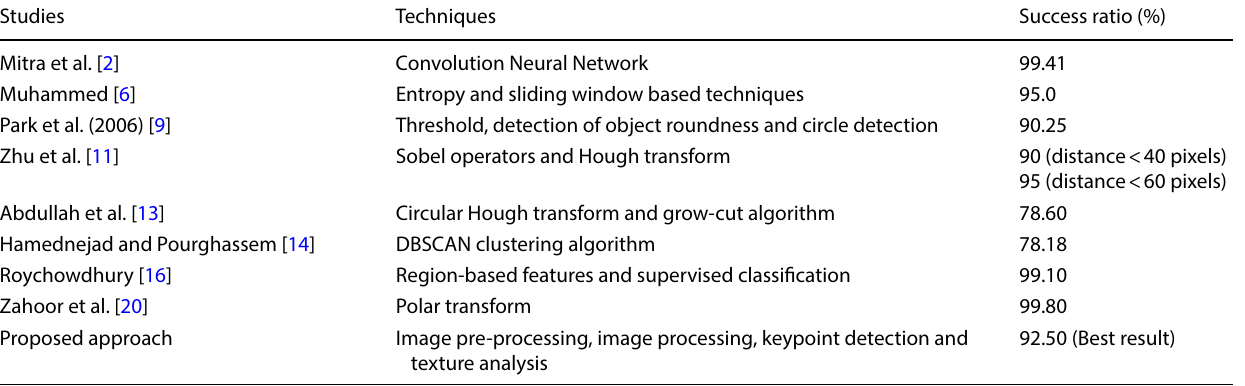
Table 2 Comparison with some of exiting methods in the literature on DRIVE dataset